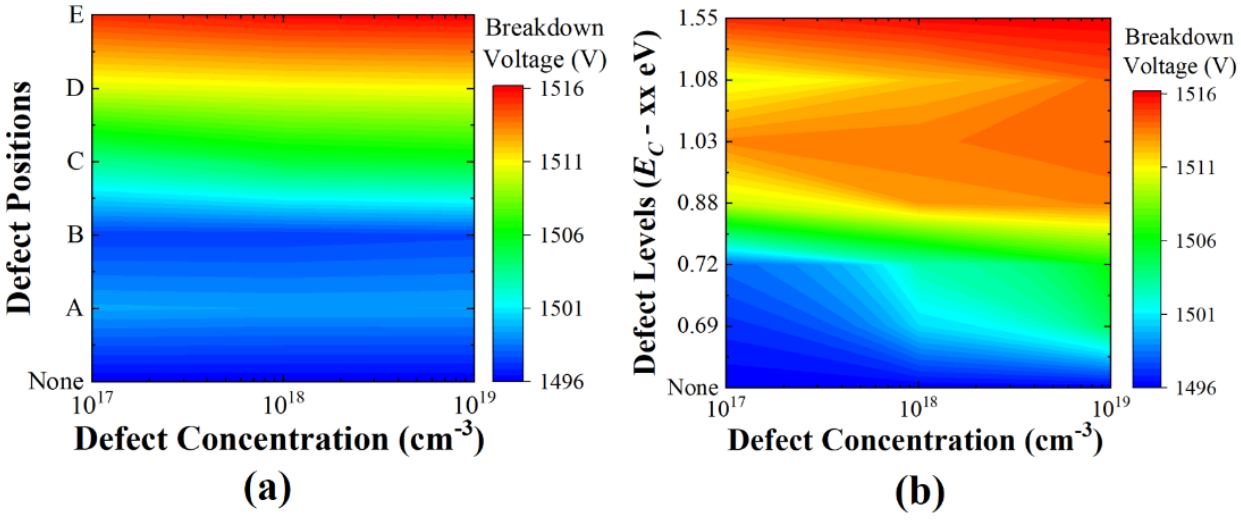
Figure 6. Effect of changes in ( a ) position and ( b ) concentration of displacement defects on break- down voltage.